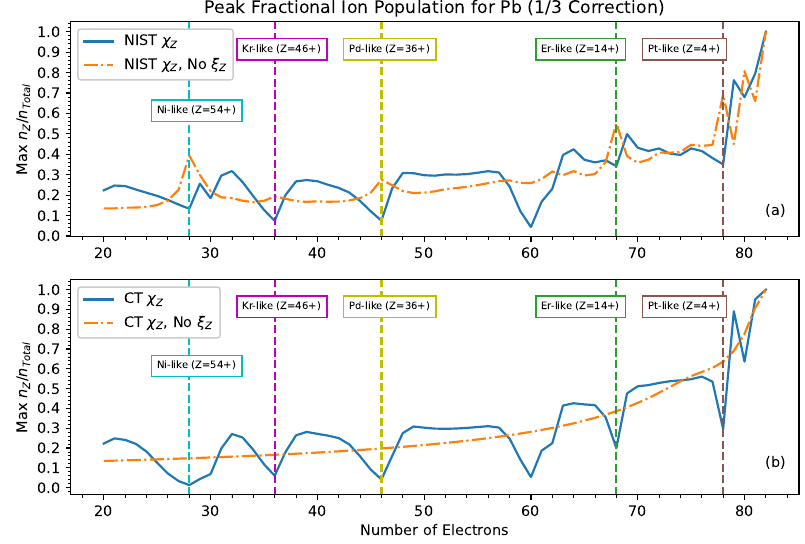
Figure 5. Plots of the peak fractional ion population Pb, calculated with the standard CR model using Equation (3) (solid lines), and from the standard CR model without the ξ Two different χ s were used, the NIST values [20] ( a ) and the estimated values from Equation (7) ( b ). Z The vertical lines mark noble gas configurations and configurations whose outermost subshell is a filled n d 10 subshell. The Er-like line corresponds to the electronic configuration: [Xe]4 f 14